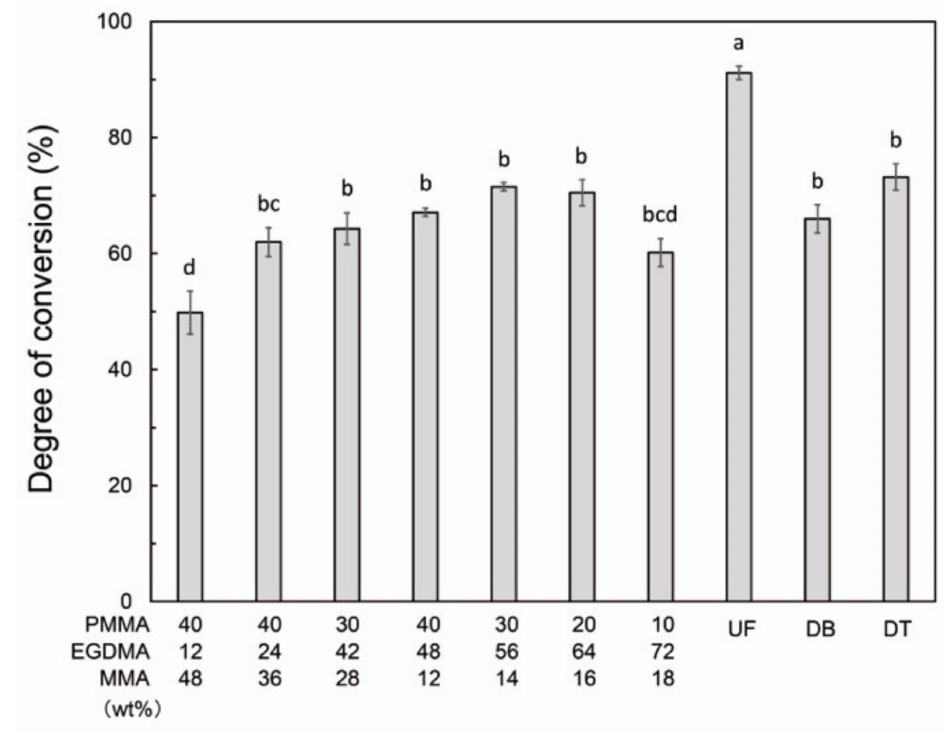
Figure 5. Degree of conversion of printable PMMA-based resins, conventional PMMA (UF), and commercial 3D-print resins (DB and DT). The different letters indicate significant differences between the groups ( p < 0.05, Tukey’s test, n = 10).